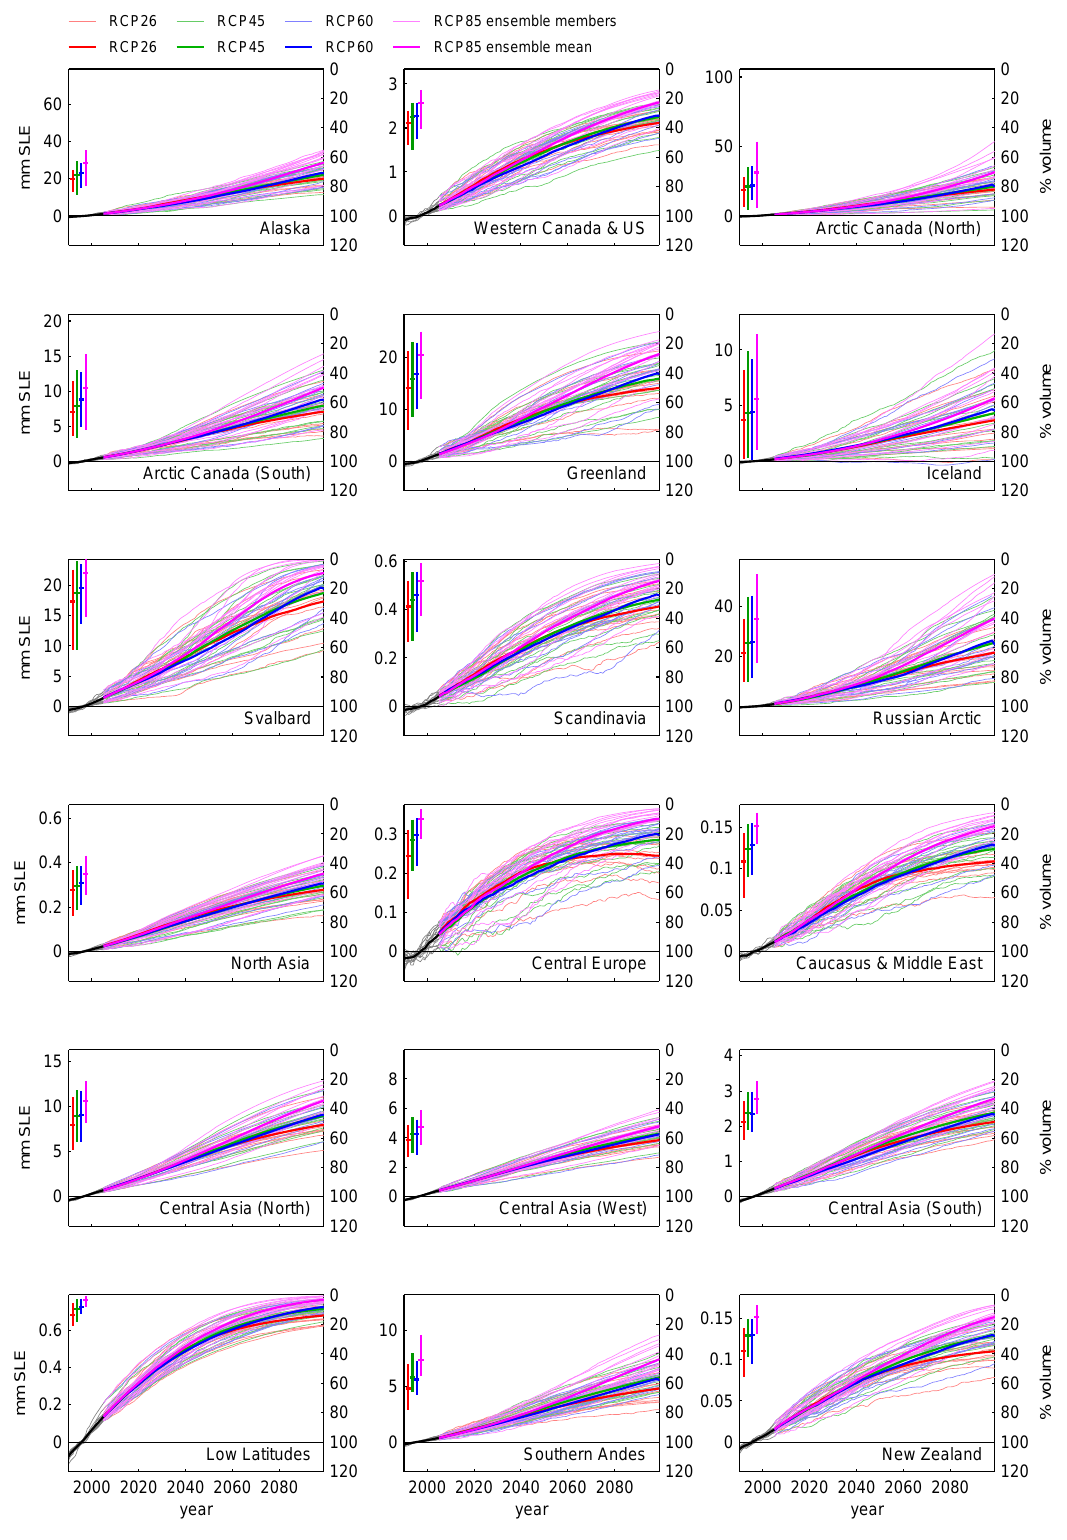
Fig. 21. Cumulative regional surface mass balances relative to the 1986–2005 mean from the model forced with CMIP5 projections, up to the year 2100. Light colored lines: model forced by individual CMIP5 ensemble members, solid lines: means of light colored lines. Crosses on the left indicate mean and range of ensemble for each RCP scenario in the year